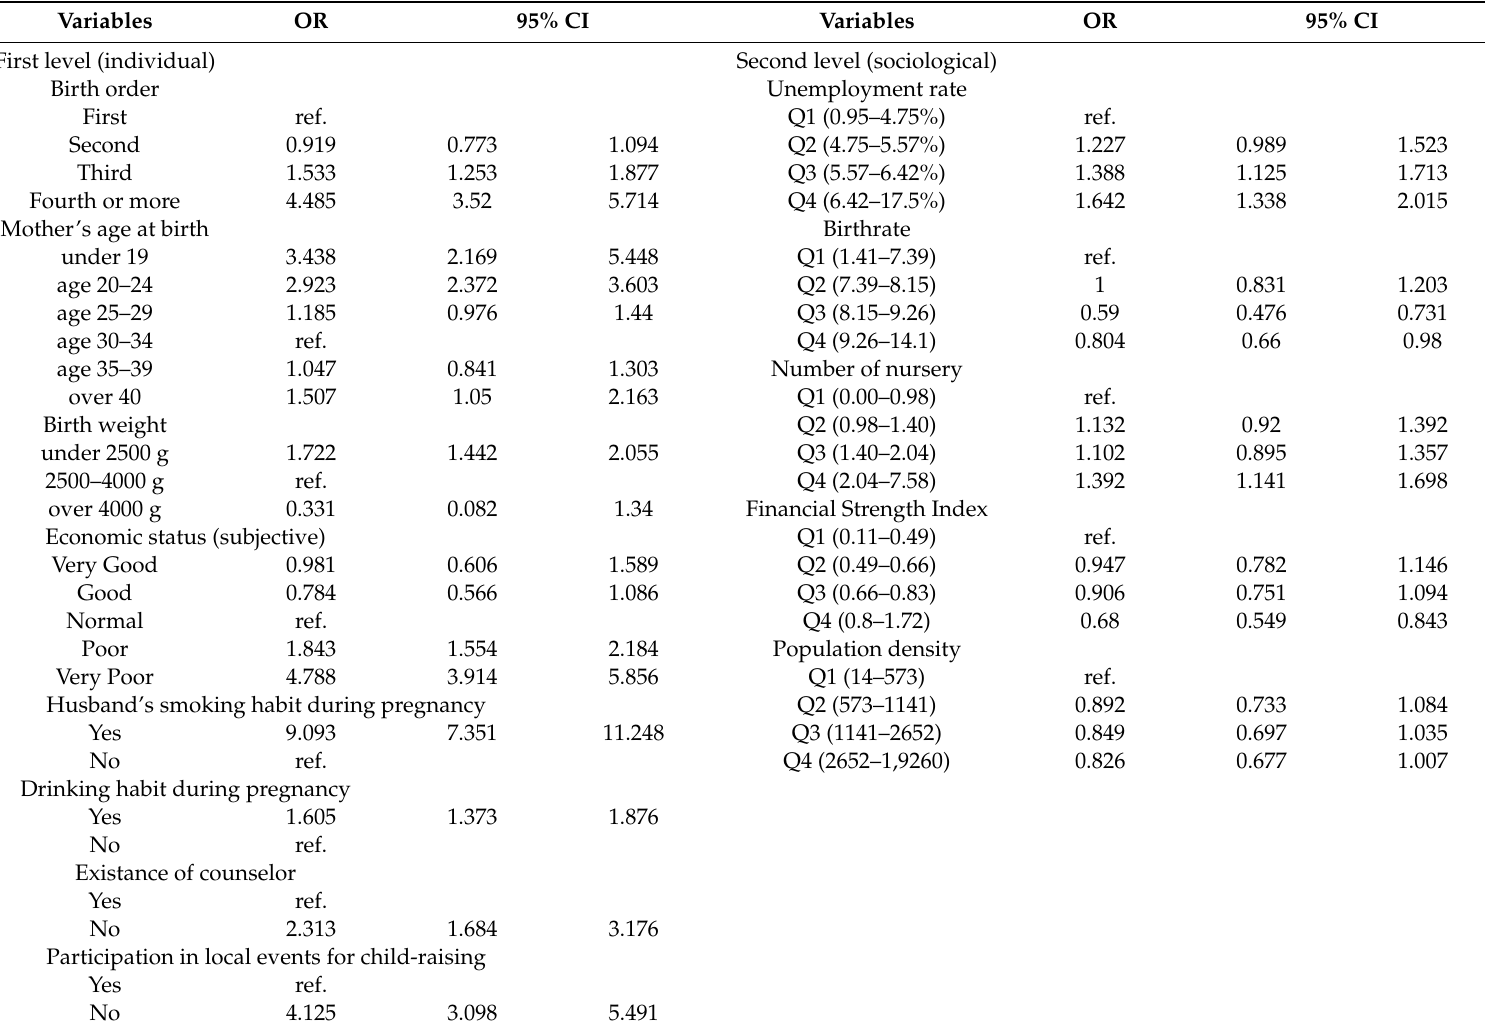
Table 3. Single logistic regression